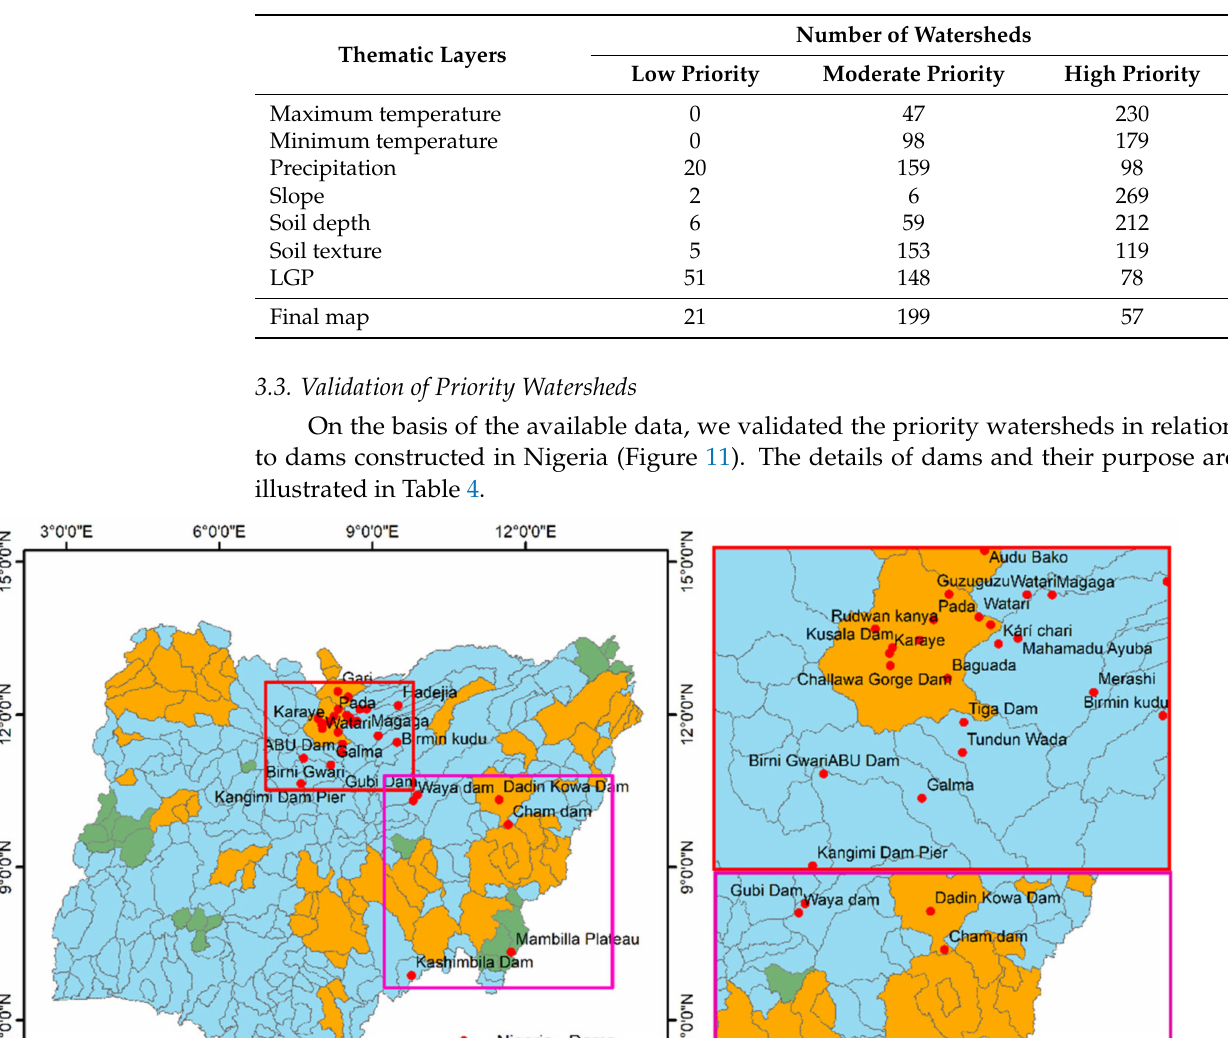
Table 3. Number of proritized watersheds by thematic layer.